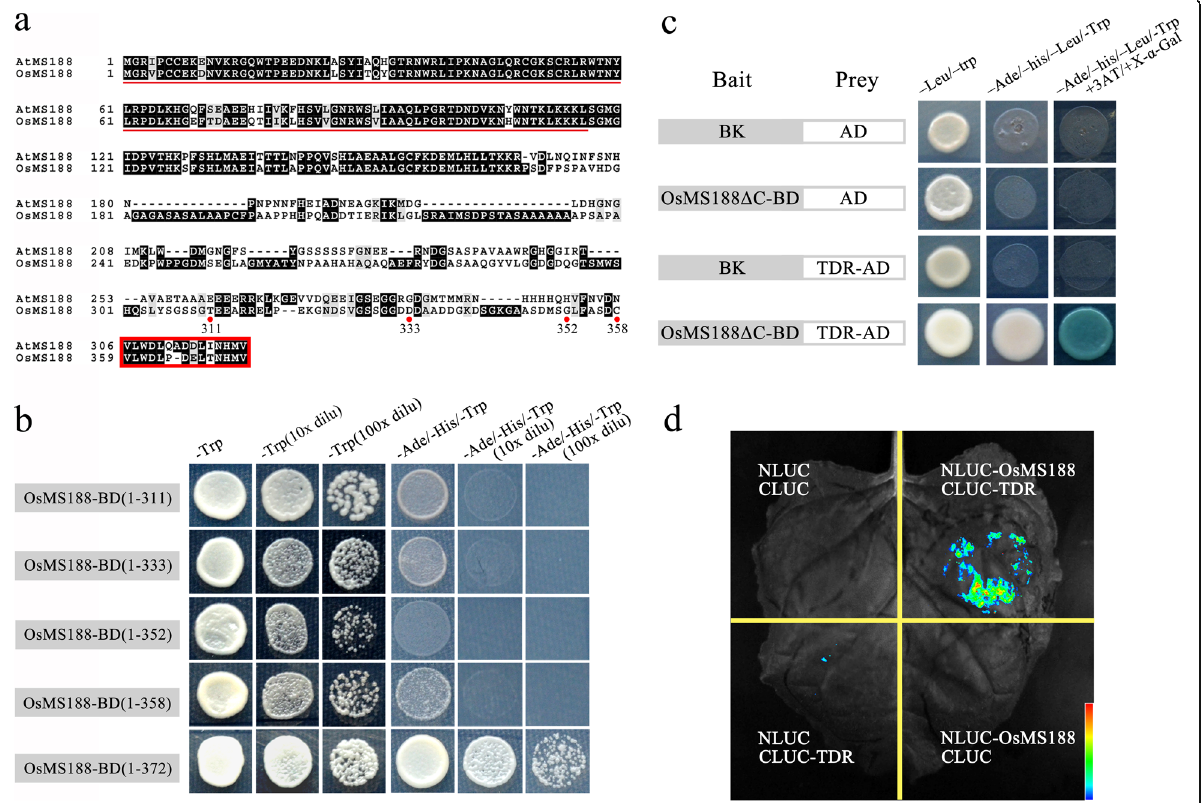
Fig. 6 OsMS188 interacts with TDR. a Amino acid sequence alignment of OsMS188 and AtMS188. The red box indicates the activation domain and the red dots indicate the number of OsMS188 amino acid sequences. b Identification of the activation domain of OsMS188. The full-length CDS of OsMS188 allowed growth on selective media lacking Leu, His and adenine. The yeast could not grow on selective media when the last 14 amino acids were deleted. c Yeast two-hybrid (Y2H) assay showing the physical interaction of OsMS188 with TDR. The OsMS188 CDS without the self-activation fragment (OsMS188 Δ C) was fused to the DNA-binding domain (BD) in pGBKT7, and the TDR CDS was fused to the GAL4 activation domain (AD) in pGADT7. The interactions are indicated by blue-coloured yeast colonies on SD/ − Ade/ − His/ − Trp/ − Leu/X-a-Gal media. d LCI assay showing the interaction between OsMS188 and TDR. Fluorescence signal intensities indicate interaction